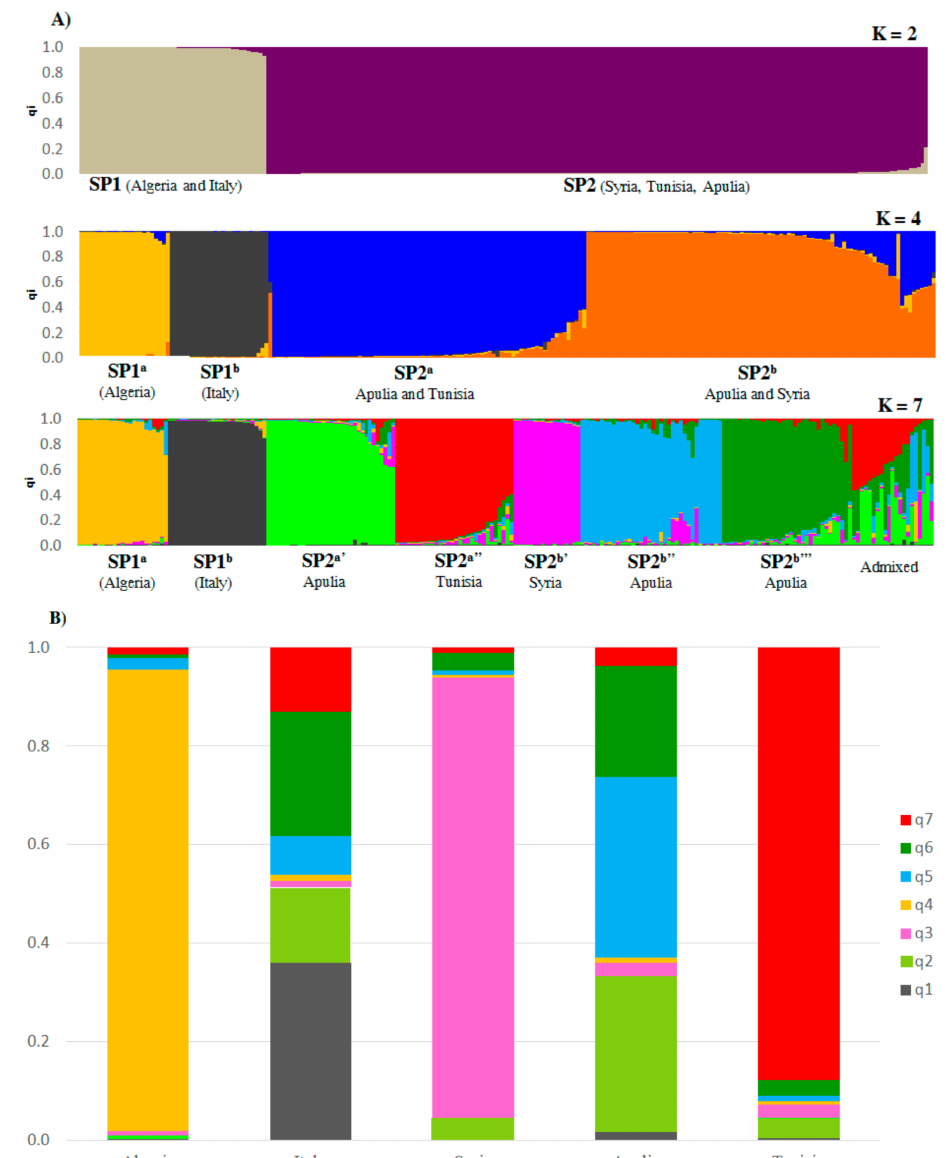
Figure 2. ( A ) The genetic structure of 218 olive accessions identified by the STRUCTURE algorithm at K = 2, K = 4 and K = 7; ( B ) The stacked bar plots showing, for olive populations originating from di ff erent geographical areas, the estimated membership coe ffi cient (qi) relative to the subpopulations identified by STRUCTURE for K = 7.